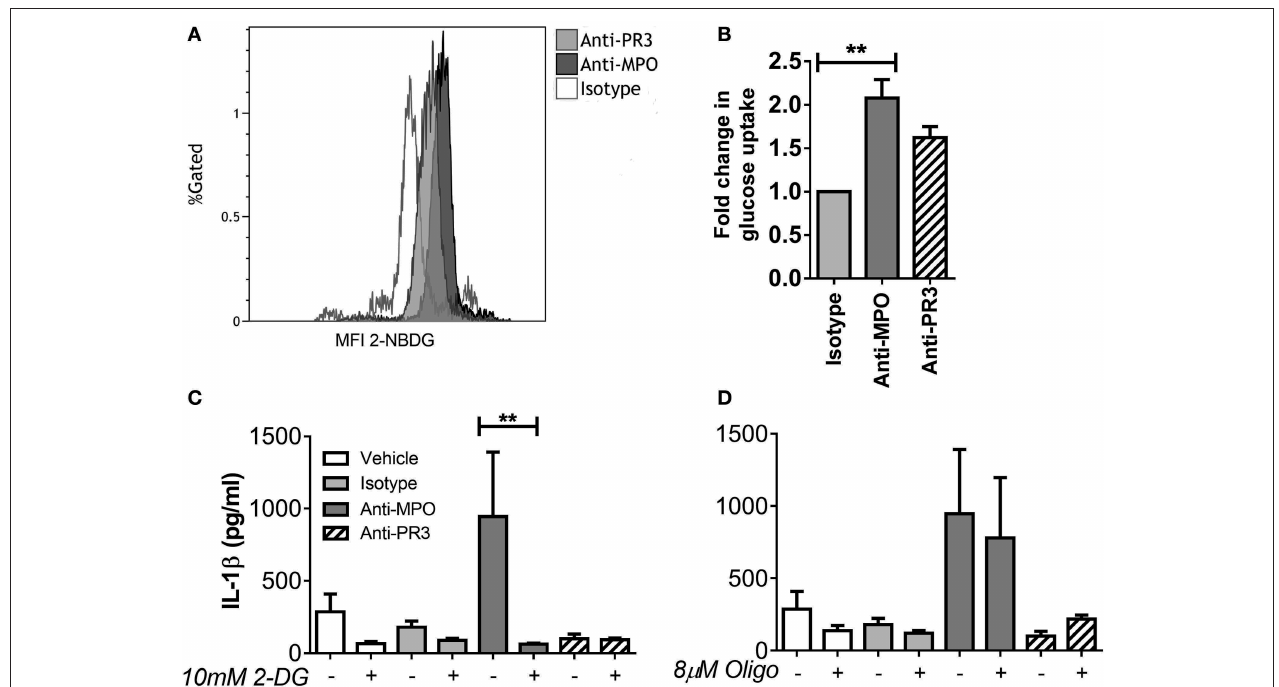
FIGURE 1 | IL-1 β production from anti-MPO stimulated monocytes requires glycolysis, but not oxphos. CD14 + monocytes were stimulated with mAb directed against MPO, PR3 or an isotype control, followed by incubation with 2-NBDG. Median fluorescence intensity (MFI) was compared between treatments. Representative overlays are shown for anti-MPO and anti-PR3 treatments (A) . Fold change in 2-NBDG uptake after antibody stimulation is shown for three independent donors (B) . CD14 + cells were incubated with either 10mM 2-DG (C) or 8 µ M oligomycin (D) and then stimulated with 5 µ g/ml mAb directed against MPO, PR3 or isotype control antibody. IL-1 β was measured in supernatants by ELISA. Data are presented as the mean and SEM. Statistical analysis was performed by students T -test (B) (** p < 0.01) or one-way ANOVA with Friedman’s post-test (C,D) (** p < 0.01) ( n =